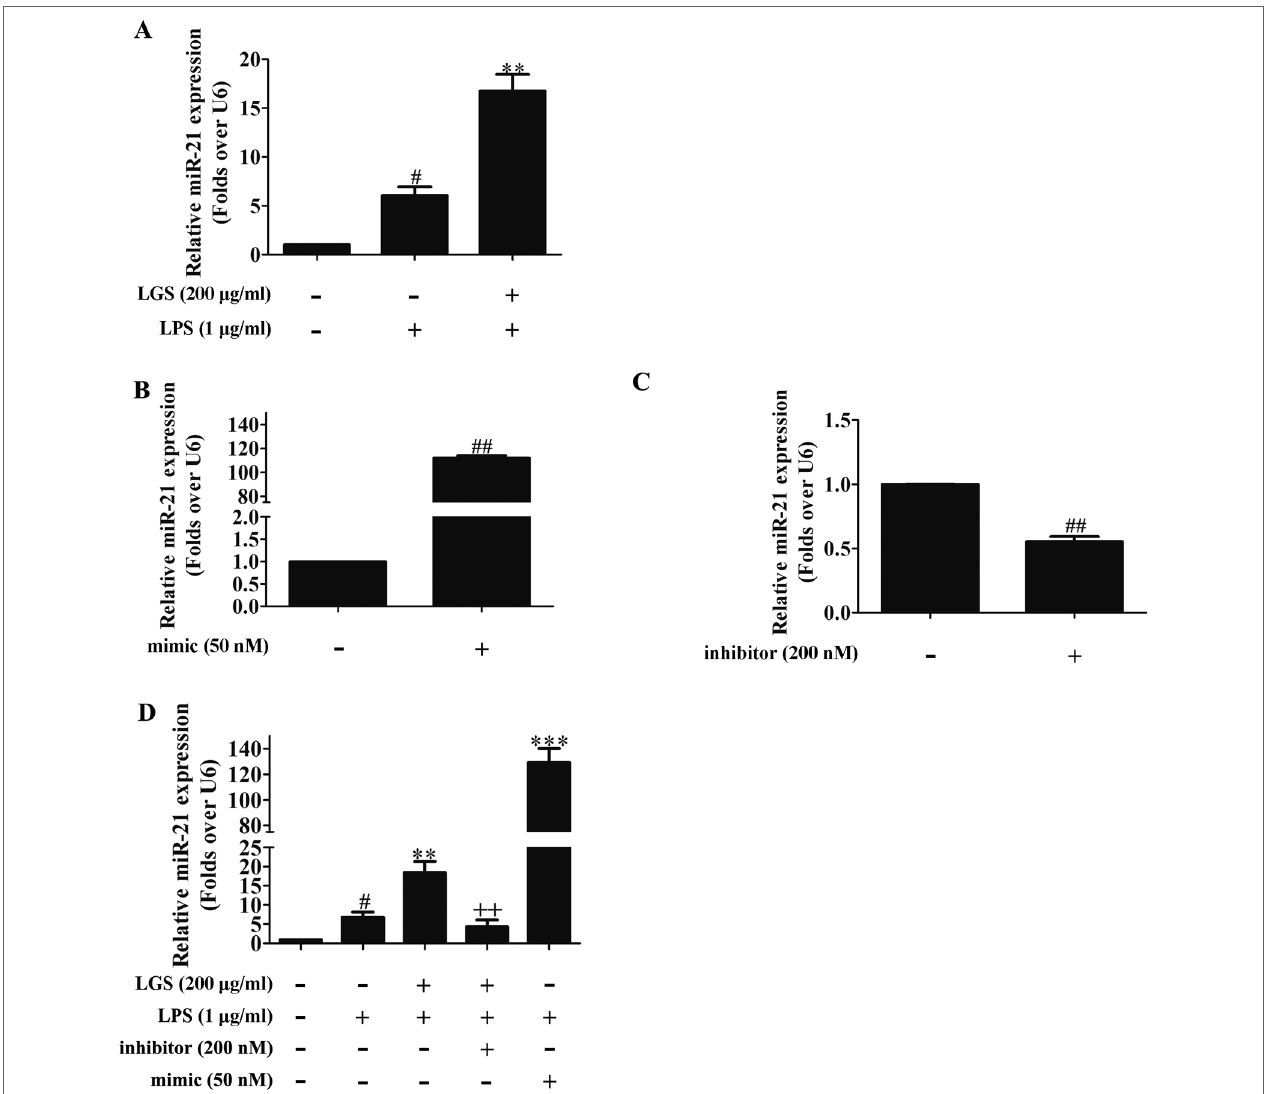
FIGURe 3 | LGS up-regulates miR-21 in RAW264.7 cells. (A) LGS enhances the expression of miR-21. Cells were incubated with LGS (200 μg/ml) and stimulated with LPS (1 μg/ml) for 24 h. (B−C) The function verification of miR-21 mimic and inhibitor. Cells were transfected with miR-21 mimic (50 nM) or inhibitor (200 nM) for 24 h. ## P < 0.01 versus control by Student’s t -test. (D) miR-21 inhibitor counteracts the up-regulation of miR-21 after LGS treatment in LPS-stimulated RAW264.7 cells. After cells were transfected with miR-21 mimic or inhibitor for 24 h, LGS (200 μg/ml) and LPS (1 μg/ml) were added to the RAW264.7 cells for 24 h. The expression of miR-21 was measured by qPCR (A−D). Data are represented as the mean ± SEM of three independent experiments. # P < 0.05 versus control, ** P < 0.01, *** P 0.001 versus LPS treatment, ++ P < 0.01 versus LGS treatment by one-way ANOVA with Tukey’s test.